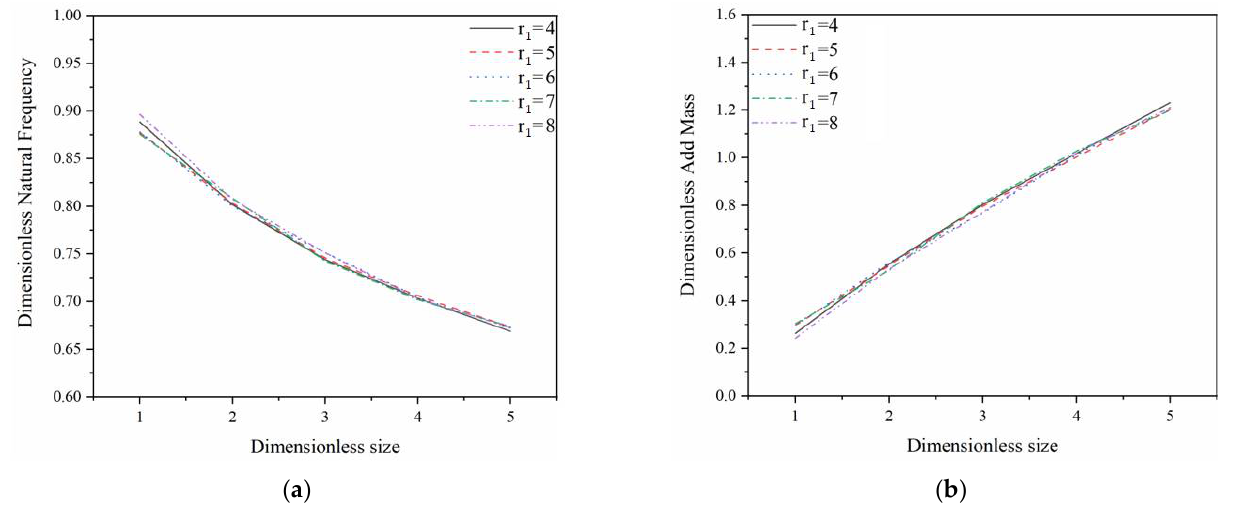
Figure 5. Dimensionless relationship of different inner radius. ( a ) Natural frequency. ( b ) Added mass.